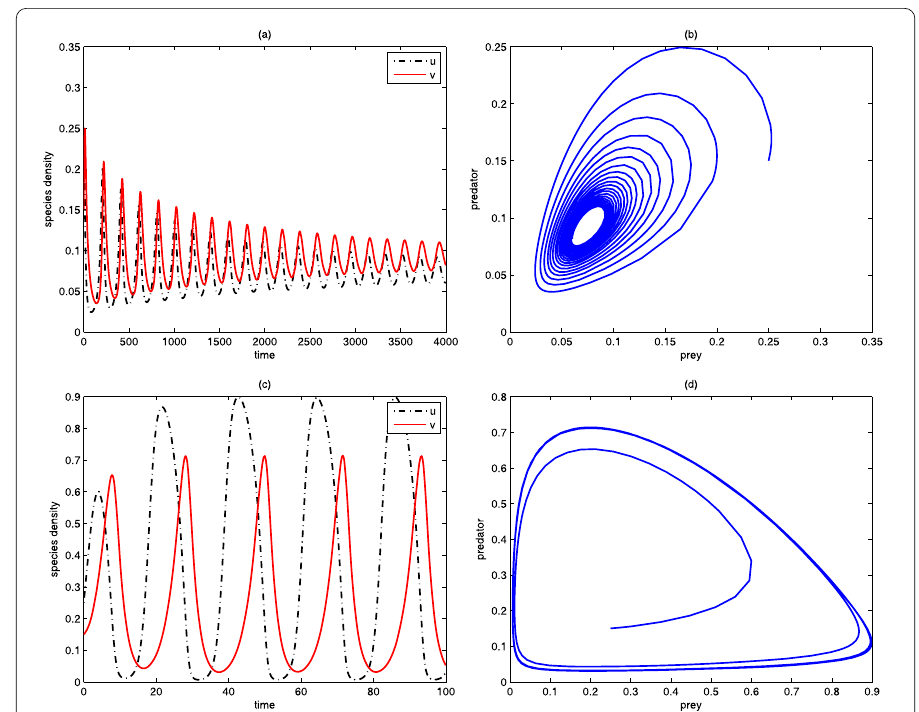
Figure 2 Time series and limit cycles for system (2.7) with kinetics (4.1) [upper row] and (4.3) [lower row], respectively. Parameter values: (a) , (b) σ = 0.5, β = 0.032, γ = 0.8, δ = 0.3 and t = 4,000. For panels (c) , (d) σ = 0.25, β = 1.05, γ = 0.5 at t = 100 and initial data ( u 0 , v 0 ) =